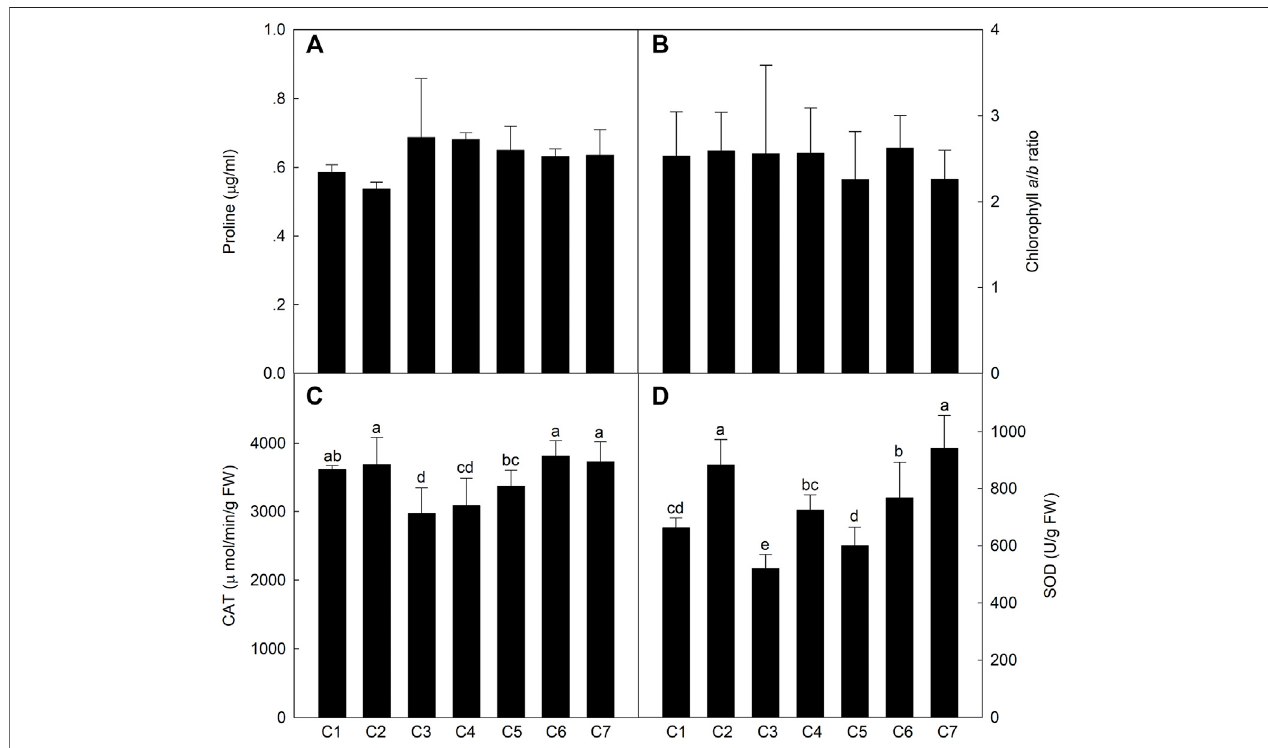
FIGURE 4 | Comparison of the content of proline (A) , chlorophyll a / b ratio (B) , activities of CAT (C), and SOD (D) in the seven Th. ponticum lines. Different letters indicate a signi fi cant difference between seven Th. ponticum lines at p < .05 level.